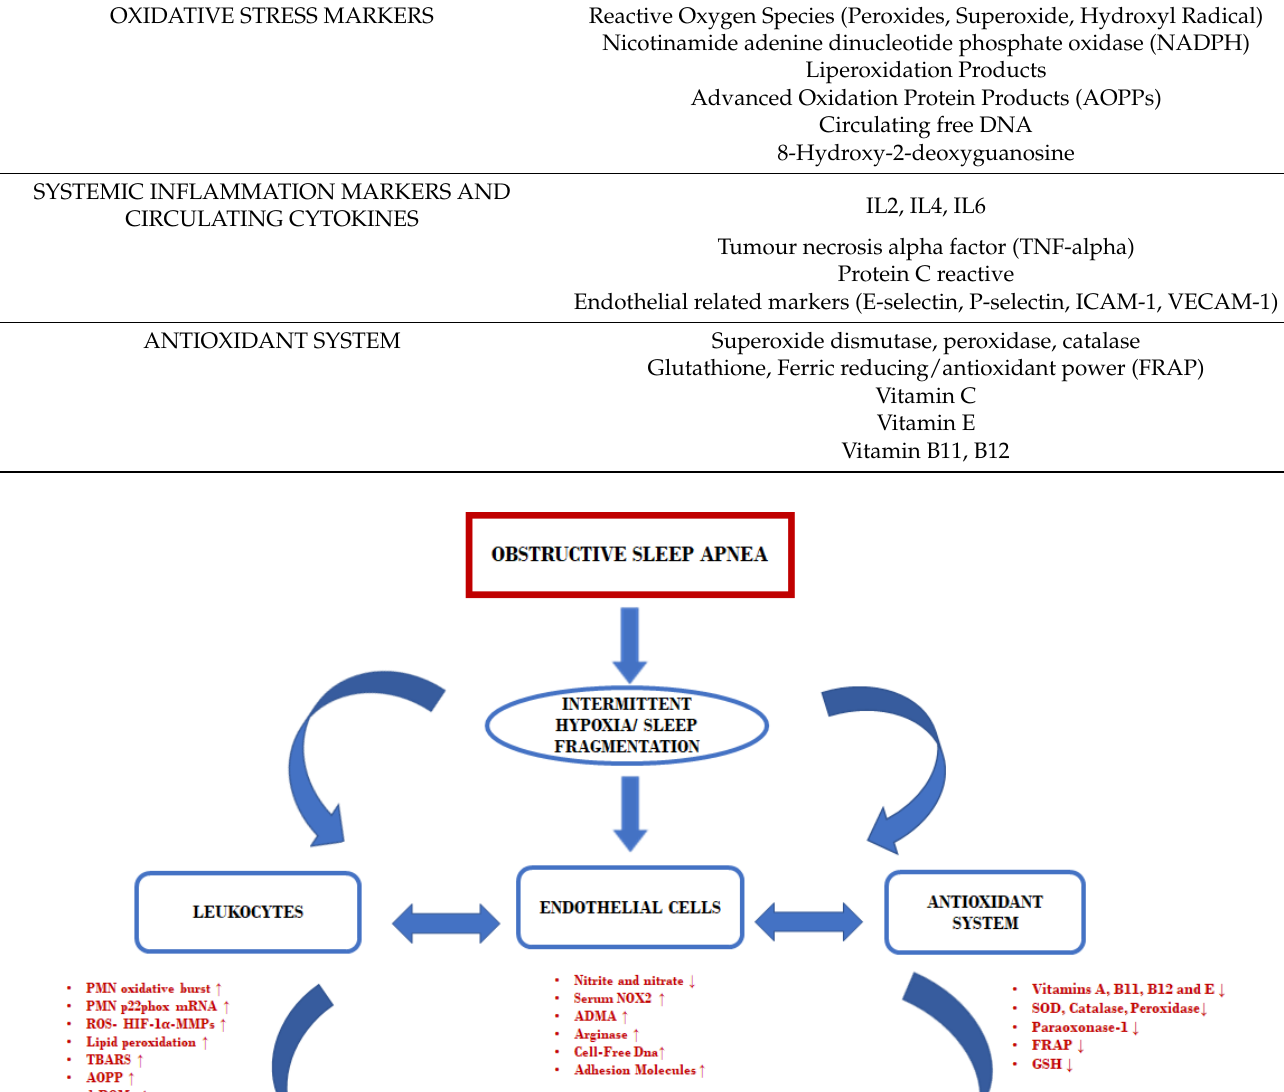
Table 1. Main classifications of obstructive sleep apnea syndrome OSAS-related immunophlogystic biomarkers.